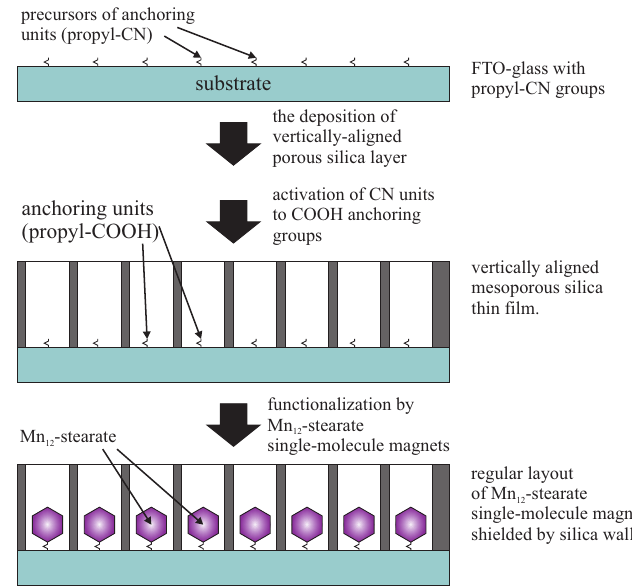
Figure 11. A schematic representation of the synthesis procedure for fabrication of vertically aligned